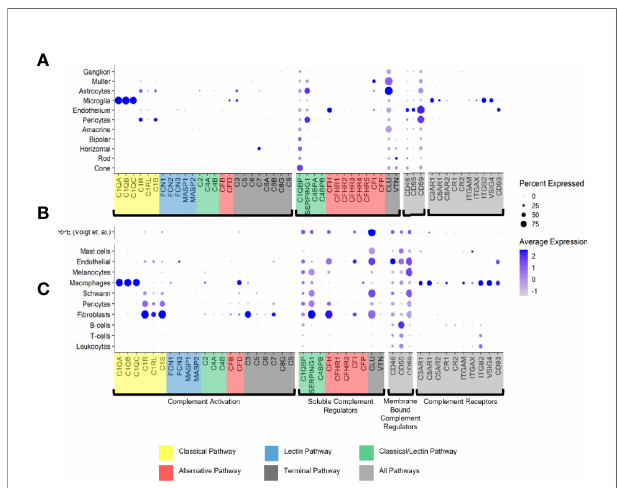
FIGURE 1 | Cell type speci fi c complement expression in the combined macula and peripheral human retina, choroid and RPE. (A) Dot plot showing expression pattern of genes of the complement pathways across cell types identi fi ed in the combined macula and peripheral retina. The dot plot was generated using Dotplot in the R Seurat package. The size of the dots represents the percentage of cells that expressed gene markers while color shows average expression levels of gene markers. (B) Reprocessed combined macula and peripheral RPE data from Voigt et al. (51). (C) Dot plot showing expression pattern of known gene markers across cell types identi fi ed in the combined macula and peripheral